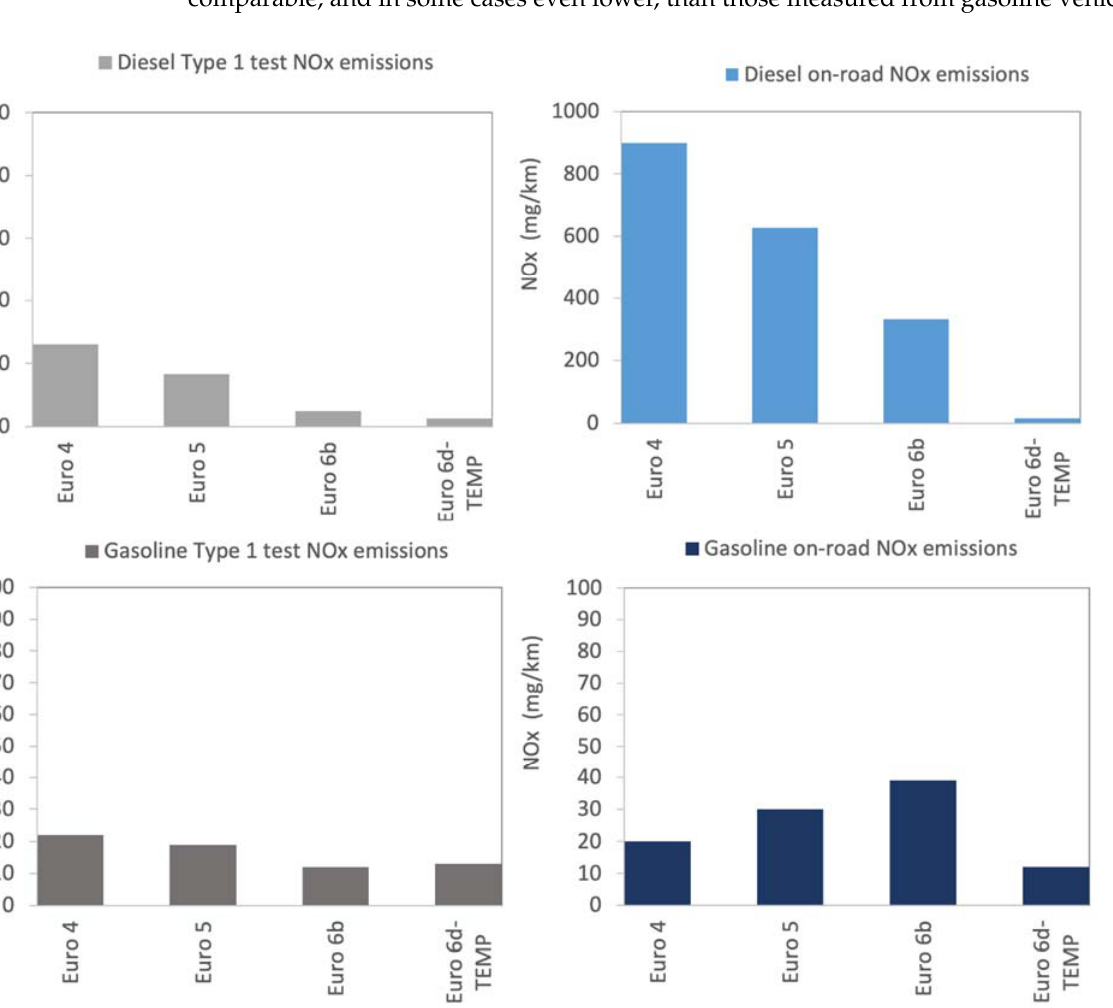
Figure 5. NOx emission factors from Diesel ( top panels ) and gasoline ( bottom panels ) light-duty vehicles tested over the Type 1 test ( left panels ) and on the road ( right panels ). Note that y-axes for gasoline vehicles are one order of magnitude lower than that of Diesel